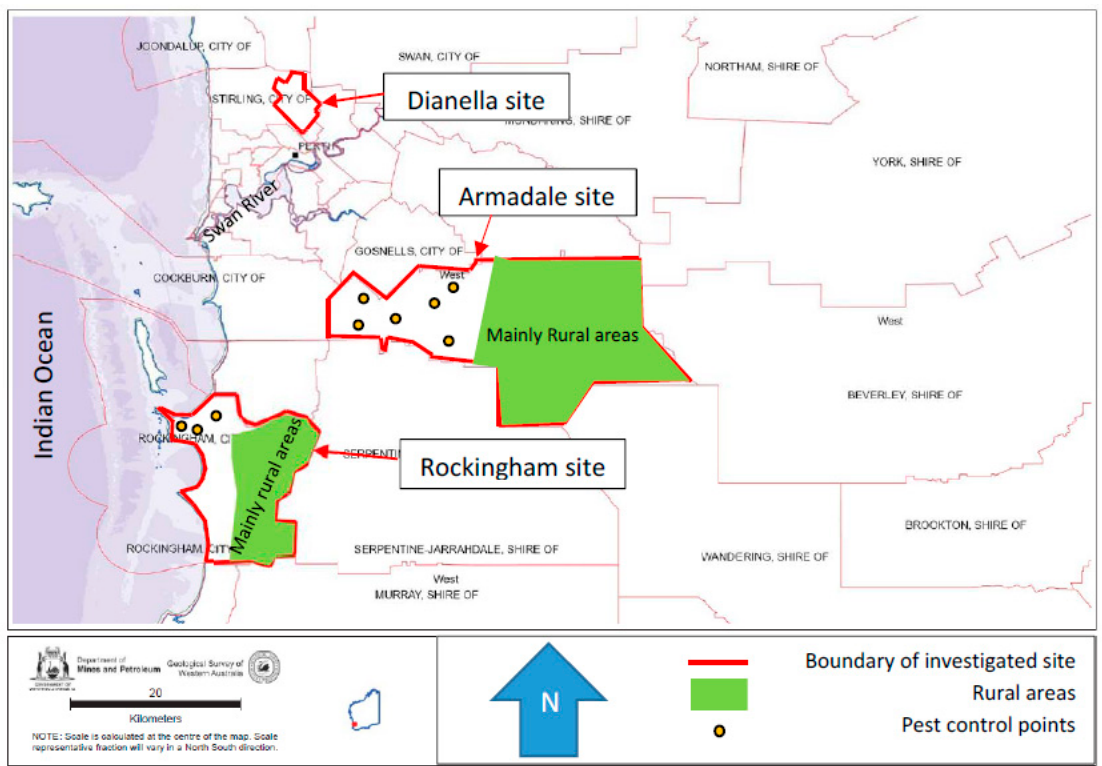
Figure 1. Depot pest control locations in Perth (idea from [39]) and contaminated groundwater spots by atrazine [40].